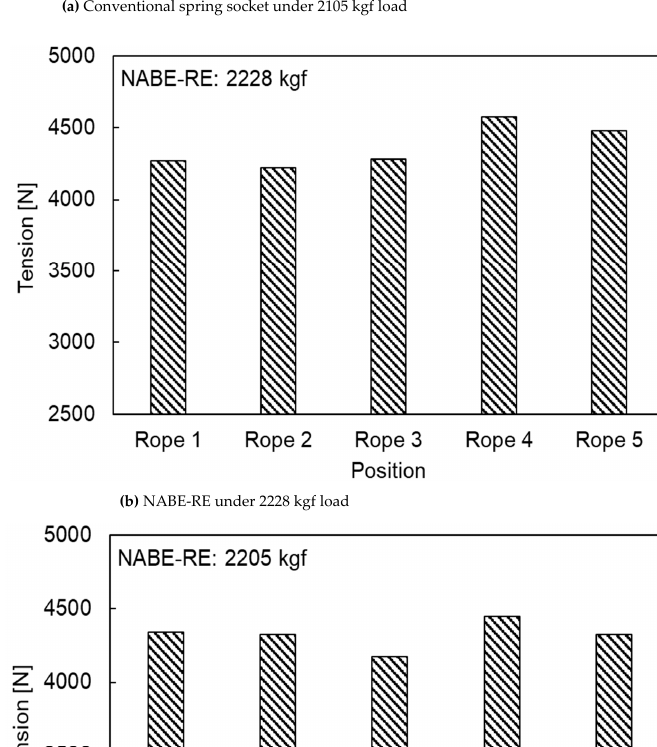
(d) NABE-RE under 1926 kgf load Figure 14. Experimental results of the tension performance test.